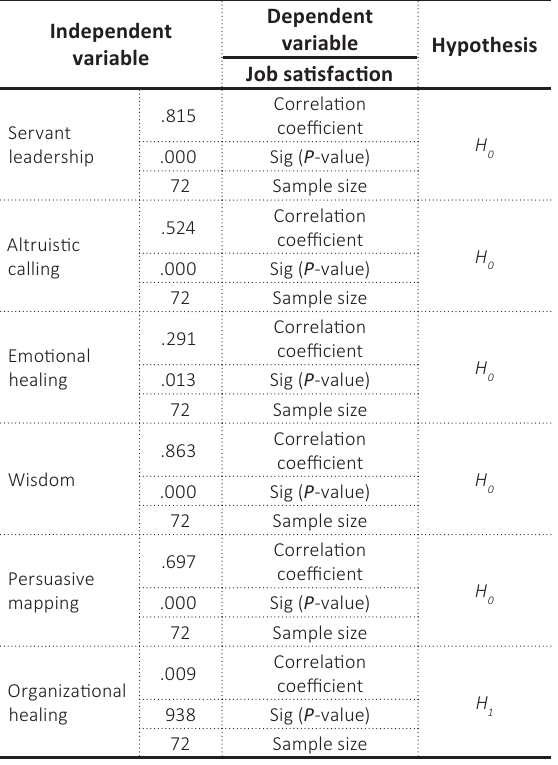
Table 4. Pearson correlation coefficient results